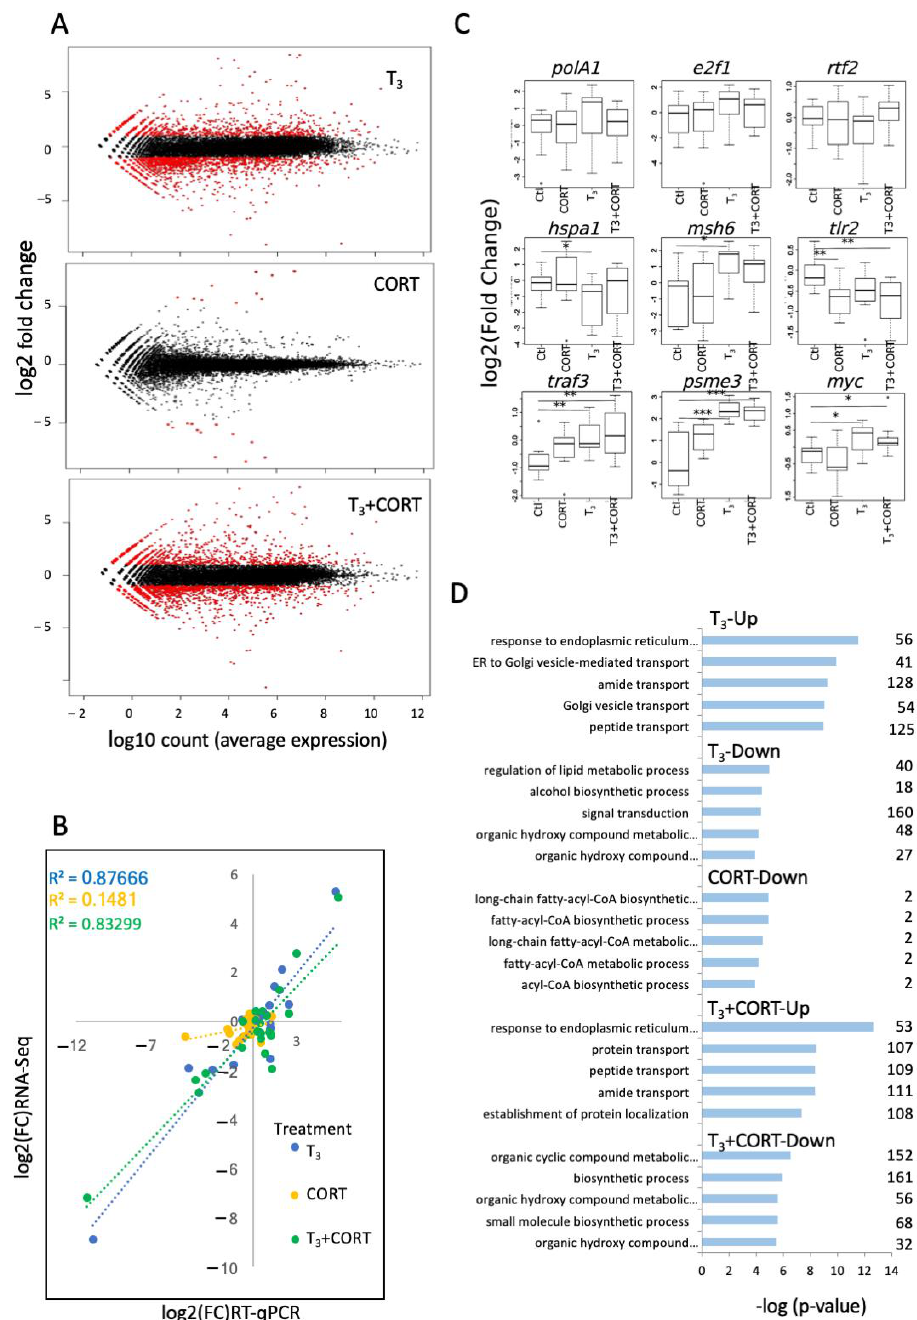
Figure 1. T 3 and CORT treatments induce major changes in gene expression: ( A ) MA-plots for DE genes following each treatment; ( B ) validation of the RNA-Seq data by RT-qPCR carried out for 21 genes selected with an average expression level above 100 reads; ( C ) RT-qPCR validation of gene expression following T 3 , CORT, and T 3 + CORT treatments (statistical significance according to Mann–Whitney test with * p < 0.05; ** p < 0.01; *** p < 0.001); ( D ) gene ontology analysis of the DE